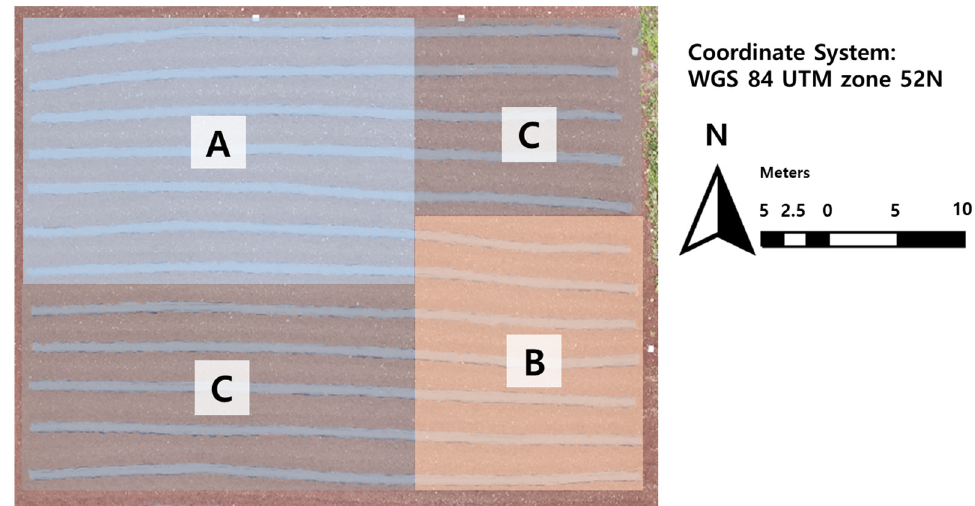
Figure 3. Heterogenous blocks in the breeding field in this